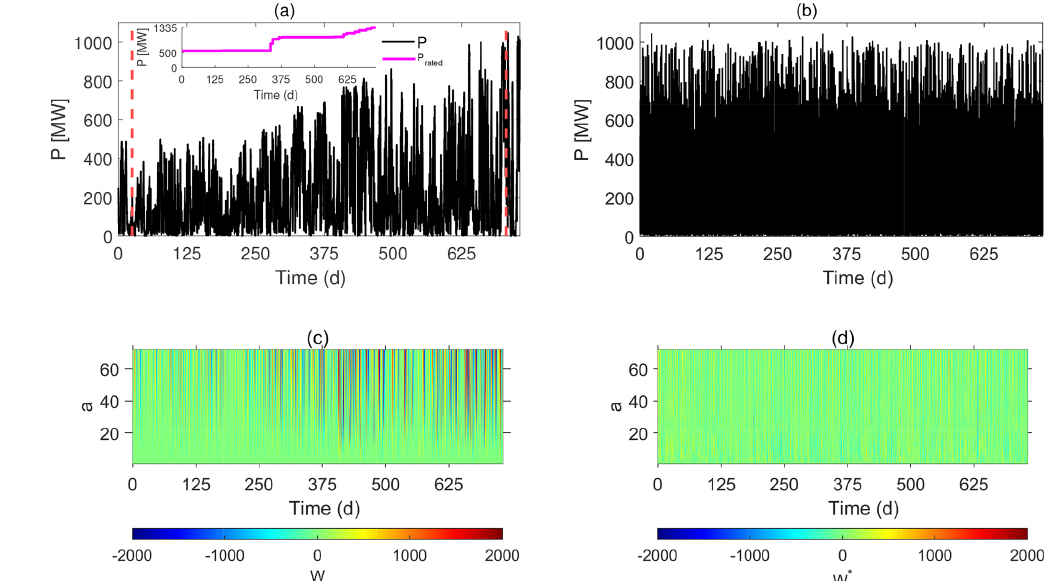
Figure 9. (a) Hourly wind power production ( P ) and rated power ( P rated ) for the aggregated Swedish energy price region SE1 for 2000– 2001. The dashed red lines represent two periods studied in further detail (see Fig. 9). (b) A randomly shuffled hourly values based on the time series in top left; (c) the continuous wavelet transform coefficient of the values in (a) ; and (d) the continuous wavelet transform coefficient of the randomly shuffled values in (b)